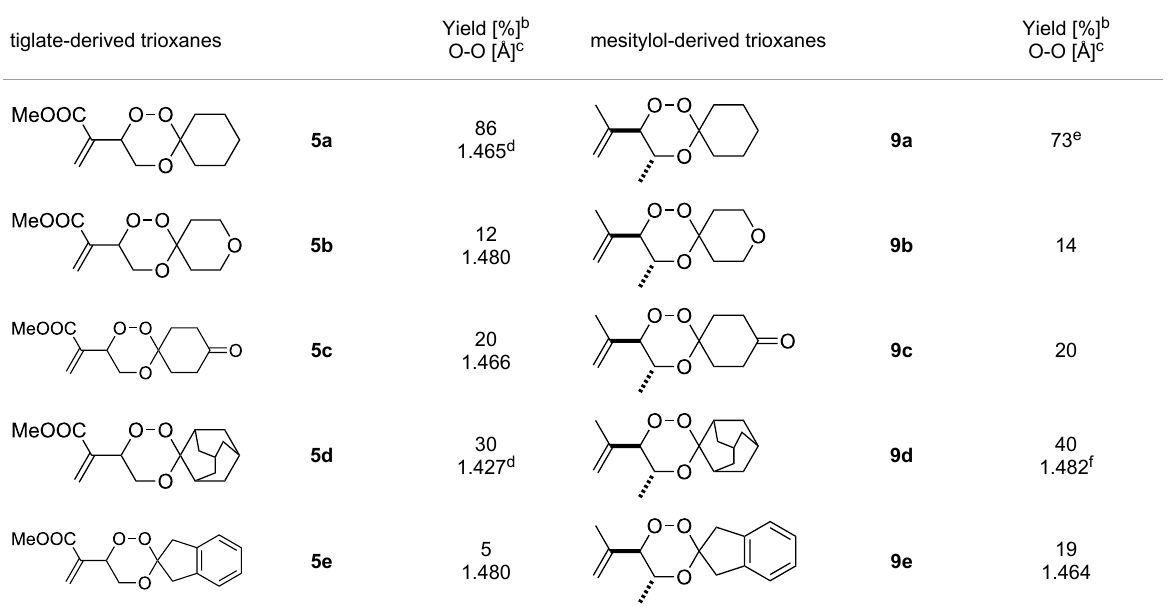
tiglate-derived trioxanes